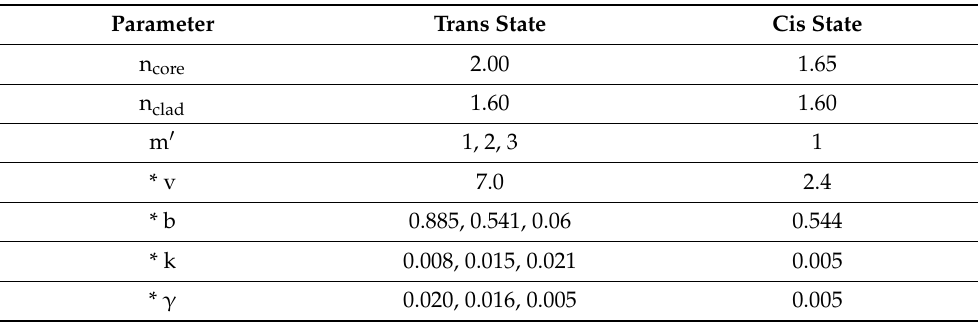
Table 1. Propagation parameters for guided 340 nm wave in PDMS–AAP waveguide of core thickness 320